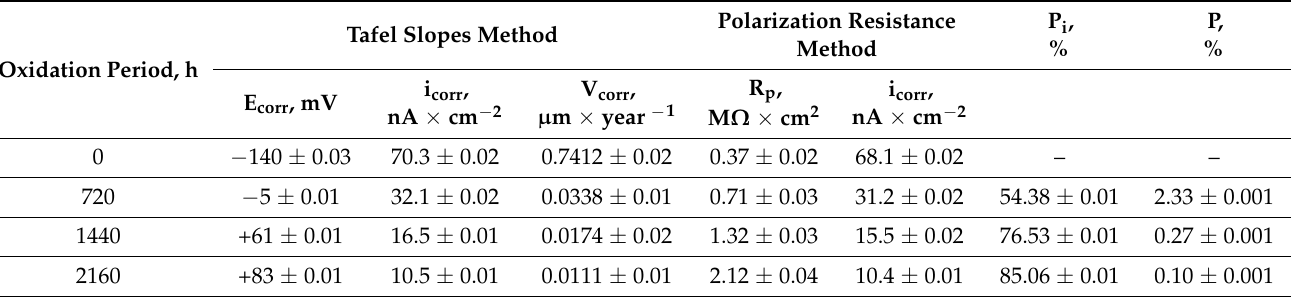
Table 5. Electrochemical parameters of CrN x -coated 310 H SS samples before and after exposure for different periods in supercritical water (550 ◦ C, 25